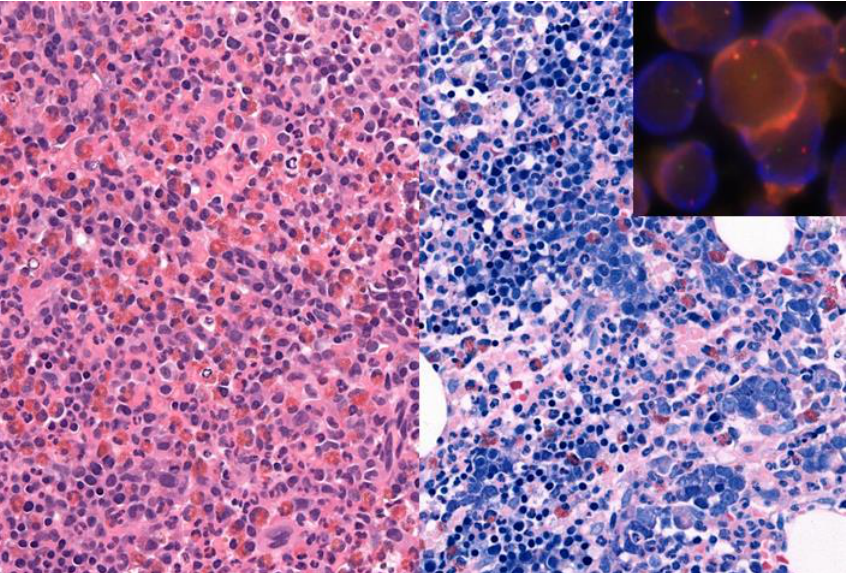
Figure 2. 71-year-old man with a hypercellular bone marrow biopsy with eosinophilia (left part: hematoxylin and eosin staining, original magnification 400×) and prominent left shifted erythro- poiesis (right part: Giemsa staining, original magnification 400×). Insert: Fluorescence in situ hy- bridization showed a JAK2 rearrangement with a JAK2 break apart probe. Next generation se- quencing identified a PCM1(36)-JAK2(11) rearrangement, in addition to DNMT3A and a NRAS mutations, resulting in a diagnosis of a myeloid/lymphoid neoplasm with PCM1-JAK2 rearrange- ment.